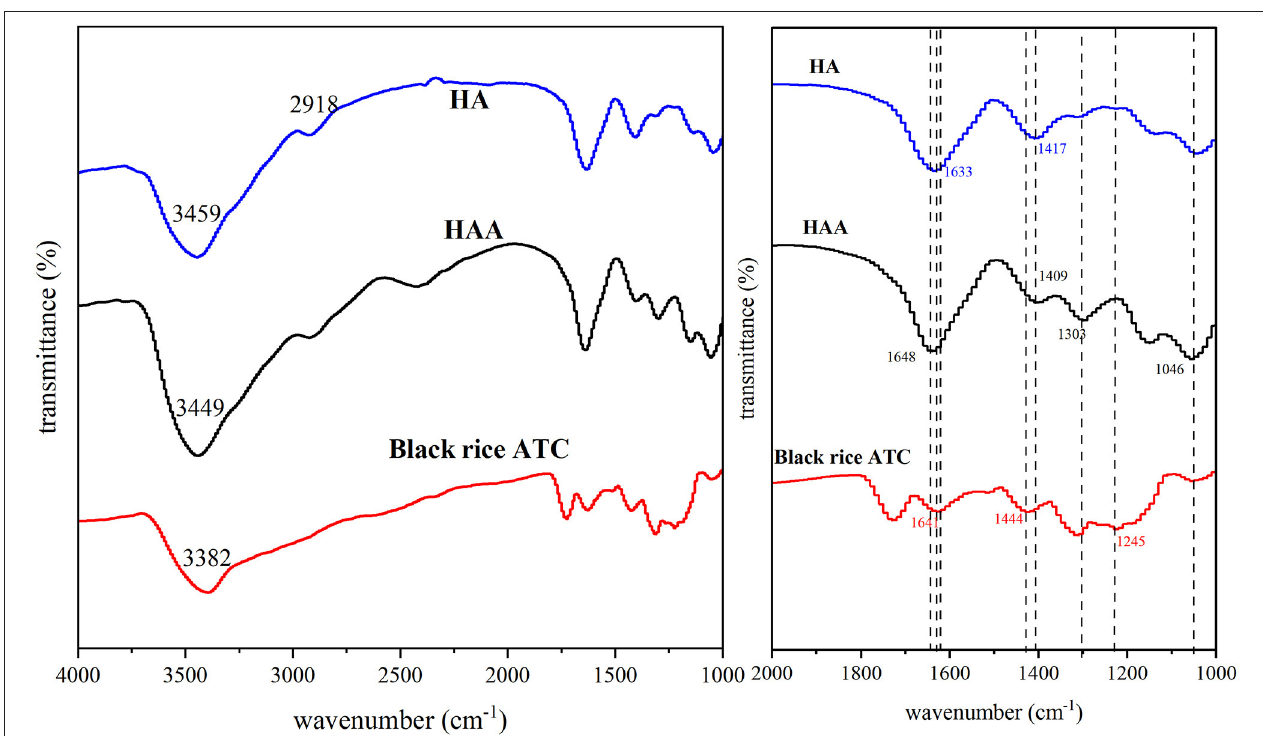
FIGURE 3 | The averaged and normalized FT-IR spectra of HA, black rice ATC, and HAA nanocomposite